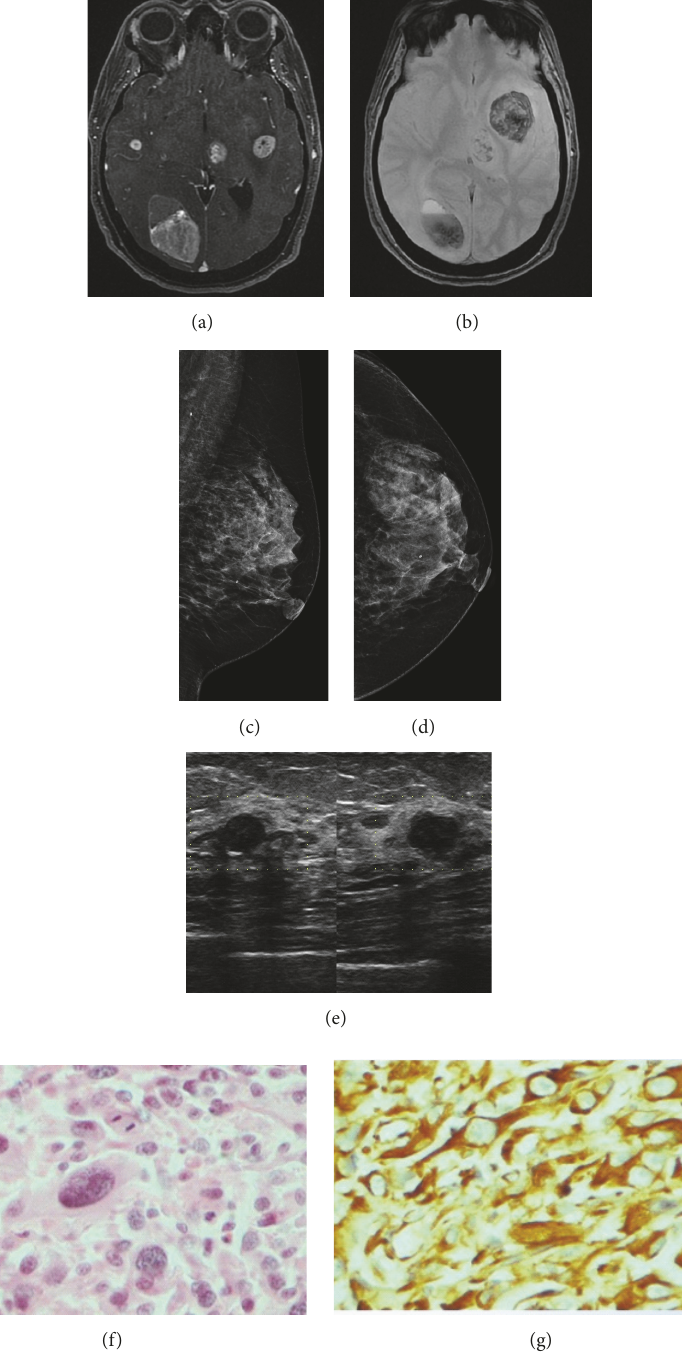
Figure 5: Case 5 . A 45-year-old woman with metastatic melanoma that presented as an isolated breast tumor. Upon interrogation, the patient reported a 1-month history of migraine and attacks of vertigo. Magnetic resonance imaging showed multiple heterogeneous enhancing masses suggesting the presence of metastatic disease ( a ). Intracranial hemorrhage focus was corroborated by fluid–fluid levels on gradient - echo imaging ( b ). Following the suspicion of metastatic disease, mammography was performed, demonstrating a subtle increase in density in both breasts ( c–d ). On ultrasound, an oval, hypoechoic mass with multilobulated margins was shown in the left breast ( e ). HE staining and immunohistochemistry analysis of the metastases. HE staining revealed the malignant cells in the breast tumor ( f ), and the immunohistochemistry analysis indicated that the cells were positive for melan-A ( g